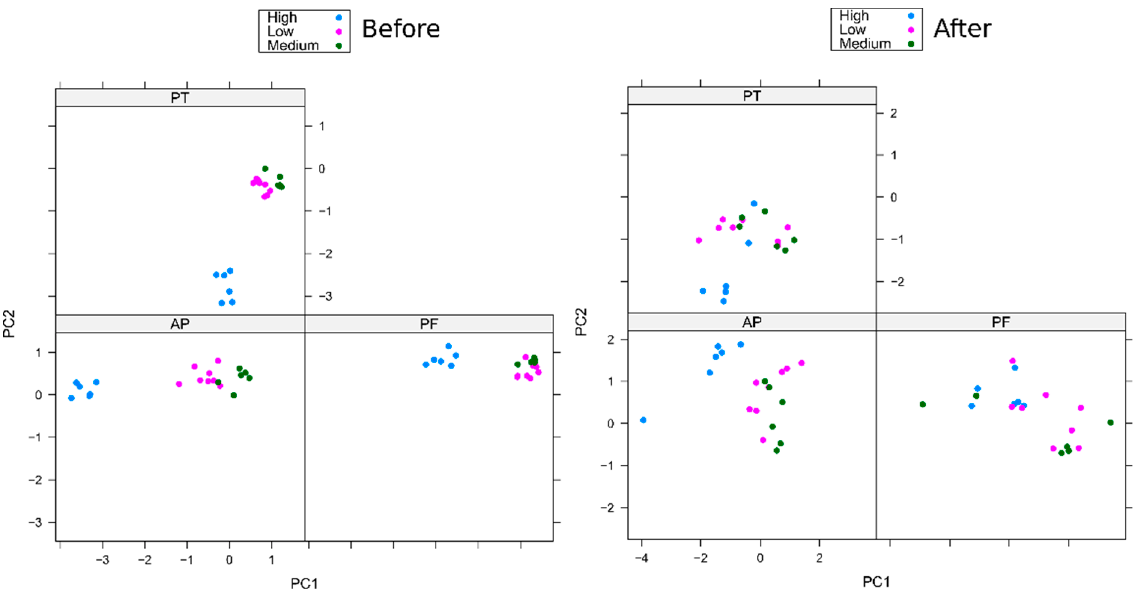
Figure 4. Colorimetric results of the three type of samples, before and after their immersion in the corresponding water environment.